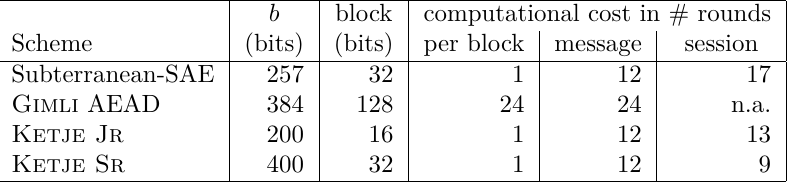
Table 4: Characteristics of some duplex-based AE schemes. Cost for message and session denote the fixed cost per message and session respectively, assuming 128-bit tags.